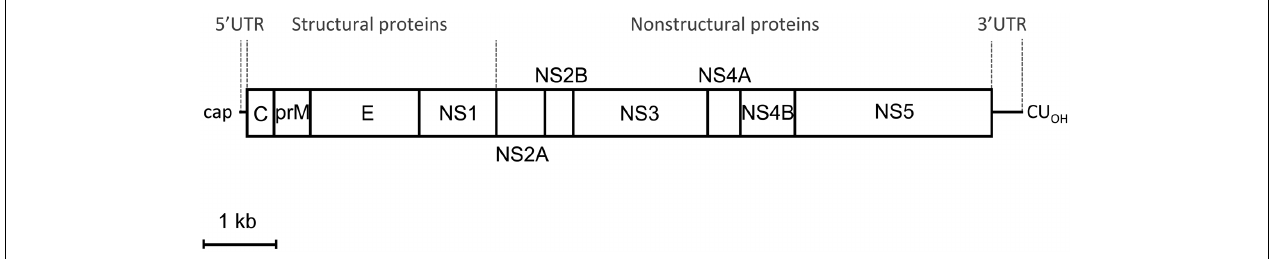
FIGURE 1 | Schematic view of Zika virus (ZIKV) genome organization. The open reading frame (ORF) (boxes) that encodes structural and non-structural proteins is flanked by two untranslated regions (UTR). The proportion of each region was calculated from the ZIKV MR766 sequence available at GenBank (NC_012532.1). Scale bar: 1